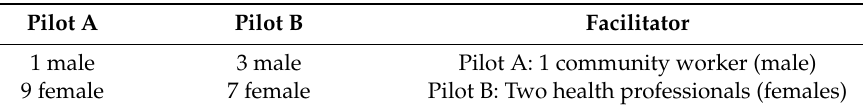
Table 1. Participants in the pilot tests for the mobile app.